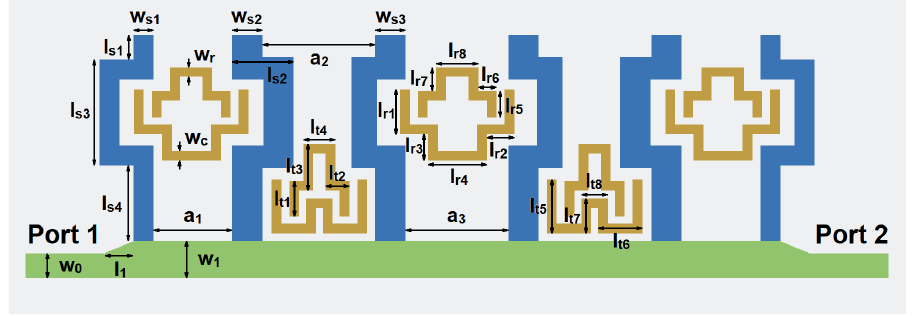
Figure 14. The proposed SSPP filter loaded with CSRRs.